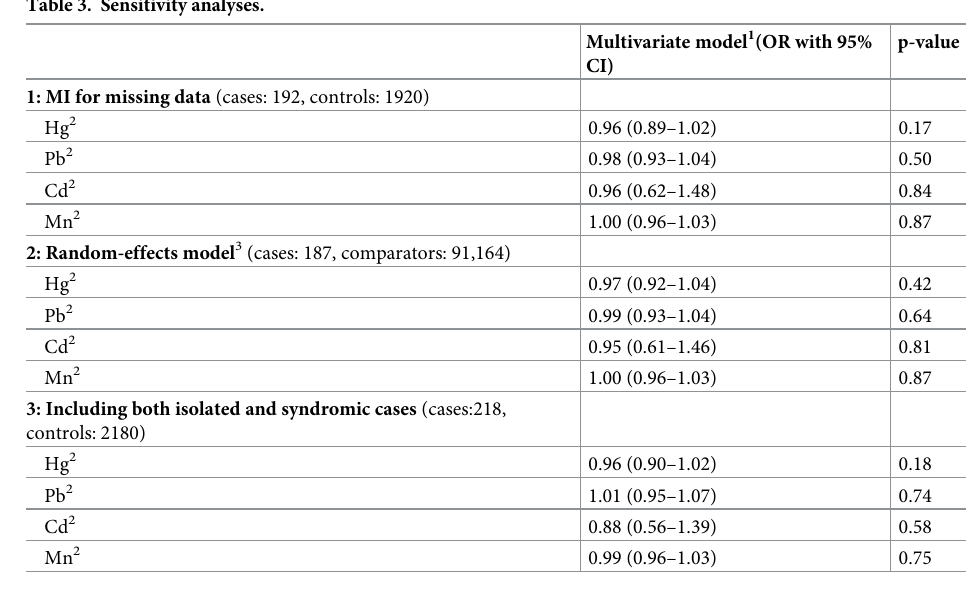
Table 3. Sensitivity